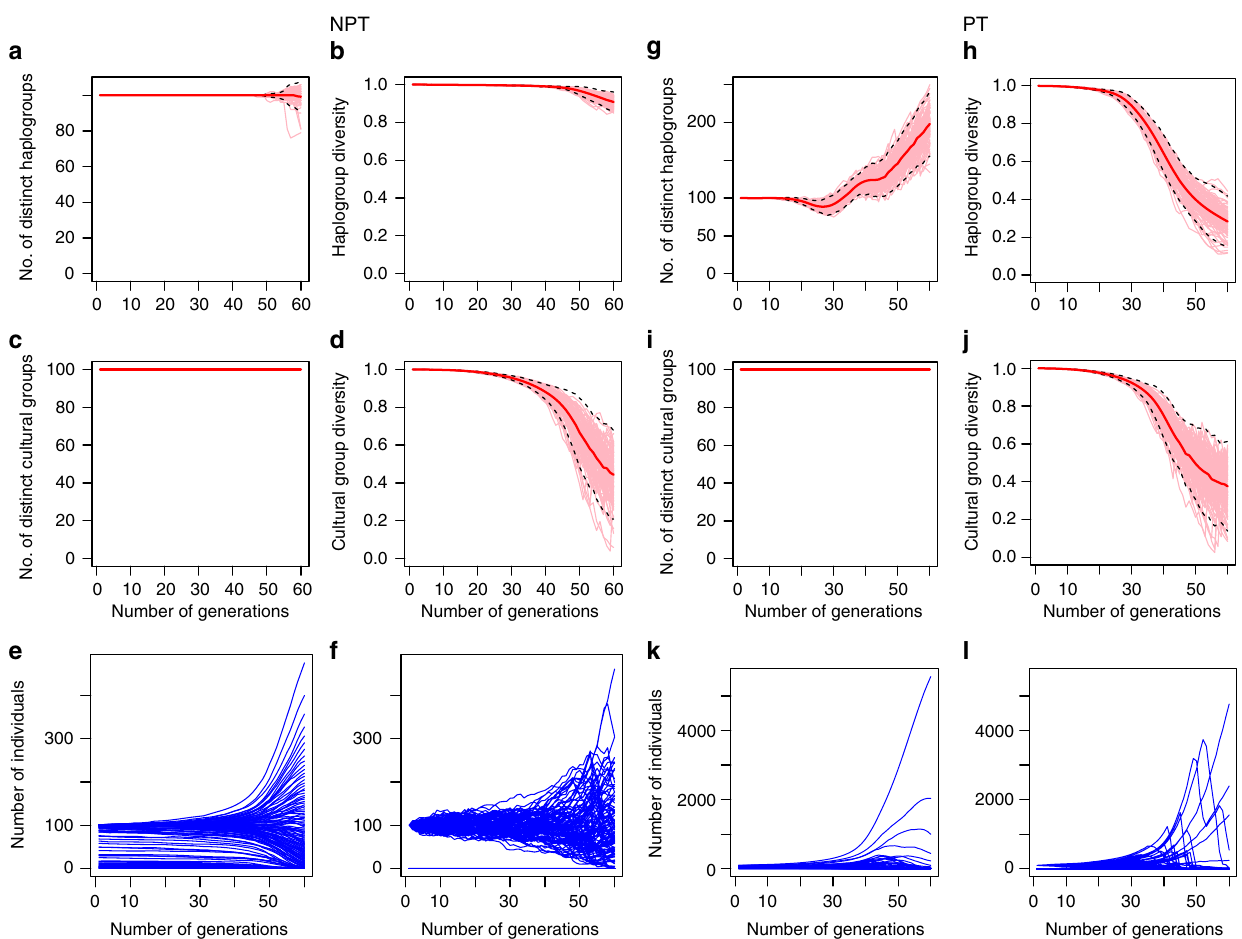
Fig. 5 Cultural group and haplogroup dynamics in competing completely non-patrilineal groups (NPT) and in competing patrilineal kin groups (PT). These correspond to Figs. 2 and 3 of Supplementary Note 3. There are 100 cultural groups, or ‘ tribes, ’ each with size 100 at the beginning, and 500 possible haplogroups. Dynamics of the number of distinct cultural groups, cultural group diversity, the number of distinct haplogroups and haplogroup diversity are obtained by averaging over 100 simulation runs (details in Supplementary Note 3). Left panels: a Number of distinct haplogroups. b Haplogroup diversity. c Number of distinct cultural groups. d Cultural group diversity. Each graph consists of 100 pink trajectories representing 100 distinct simulation runs, and one thick solid red trajectory representing the average of the 100 pink trajectories. Black dotted lines representing con fi dence intervals covering two standard deviations from this mean trajectory. Note that the total number of haplogroups does not increase in this model as each haplogroup-cultural group pair has too few representatives for the mutation step of our algorithm to operate on; this is a methodological artifact and not a signi fi cant result. e The mean dynamics of the size of each of the 500 haplogroups over T = 60 generations. f The dynamics of each of the 500 haplogroups for one single run. Right panel: g – j Dynamics for the patrilineal con fi guration, correspond to a – d of the non-patrilineal con fi guration. Similarly, k , l correspond to e ,